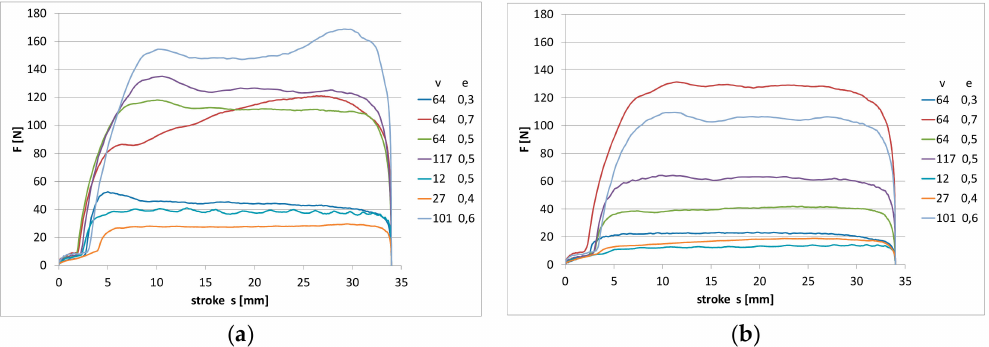
Figure 3. The measured values of friction force during one stroke of the rod: ( a ) nitrile rubber (NBR) pure material; ( b ) NBR material with graphite filler; v {mm / s}; e {mm}.